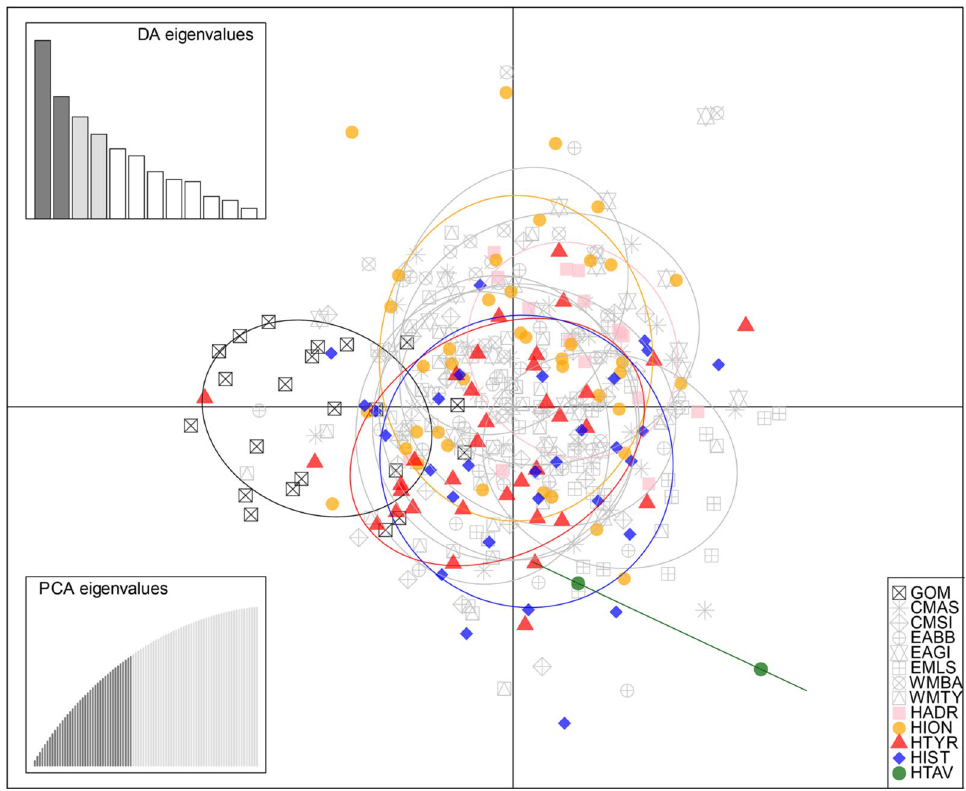
Figure 2. Discriminant analysis of principal components scatterplot showing how historical (archival and archaeological, denoted with H) sample groups relate to contemporary reference populations of the Gulf of Mexico (GOM) and the eastern Atlantic and Mediterranean. DAPC cluster ellipses were set to contain 95% of genotypes. Discriminant analysis (DA) eigenvalues and principal component analysis (PCA) eigenvalues were selected as displayed to avoid overfitting, utilising the optim.a.score approach within the R package adegenet.